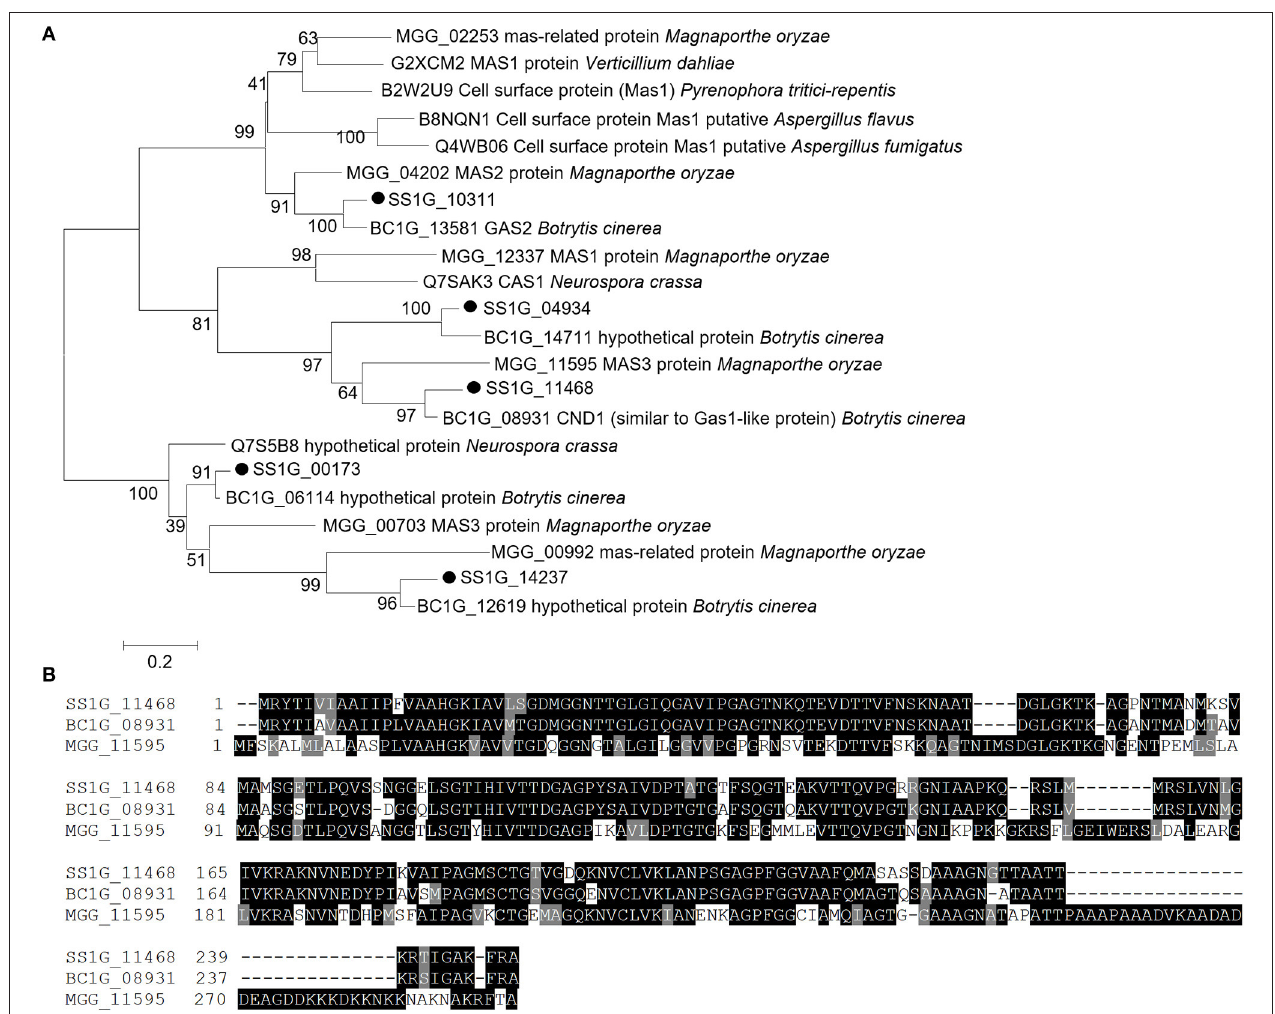
FIGURE 1 | Sequence and phylogenetic analysis of MAS-related genes of Sclerotinia sclerotiorum . (A) Phylogenetic analysis of S. sclerotiorum SS1G_11468 and other homologous MAS-related proteins from Botrytis cinerea , Magnaporthe oryzae , Pyrenophora tritici-repentis , Aspergillus flavus , Verticillium dahliae , Aspergillus fumigatus , and Neurospora crassa . (B) Multiple alignment of the protein sequences of SS1G_11468, CND1 in Botrytis cinerea (BC1G_08931) and MAS3 in Magnaporthe oryzae (MGG_11595). Phylogenetic analysis was performed using MEGA 6.0 software using the maximum likelihood method.